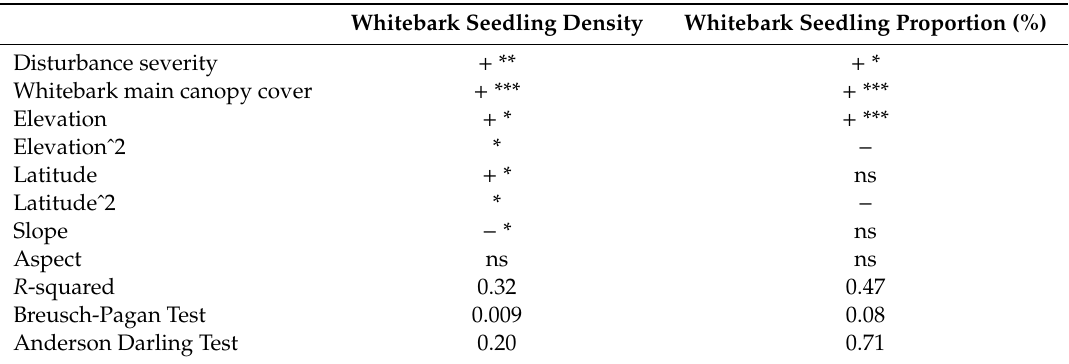
Table 1. Multiple regression results for Study #1, plot-based models. Explanatory variables in the first column, and response variables in the first row for each of two models. Quadratic terms for elevation and latitude were introduced into models where they improved fits.